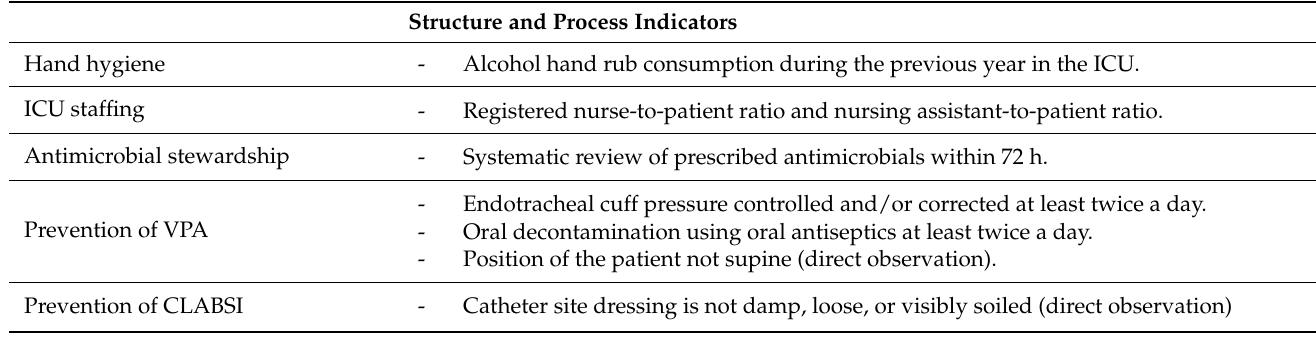
Table 3. Structure and process indicators for HAI prevention in ICUs [76]. Structure and Process